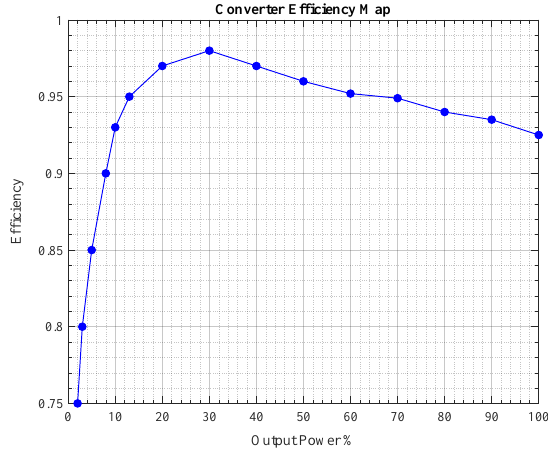
Figure 6. Converter efficiency